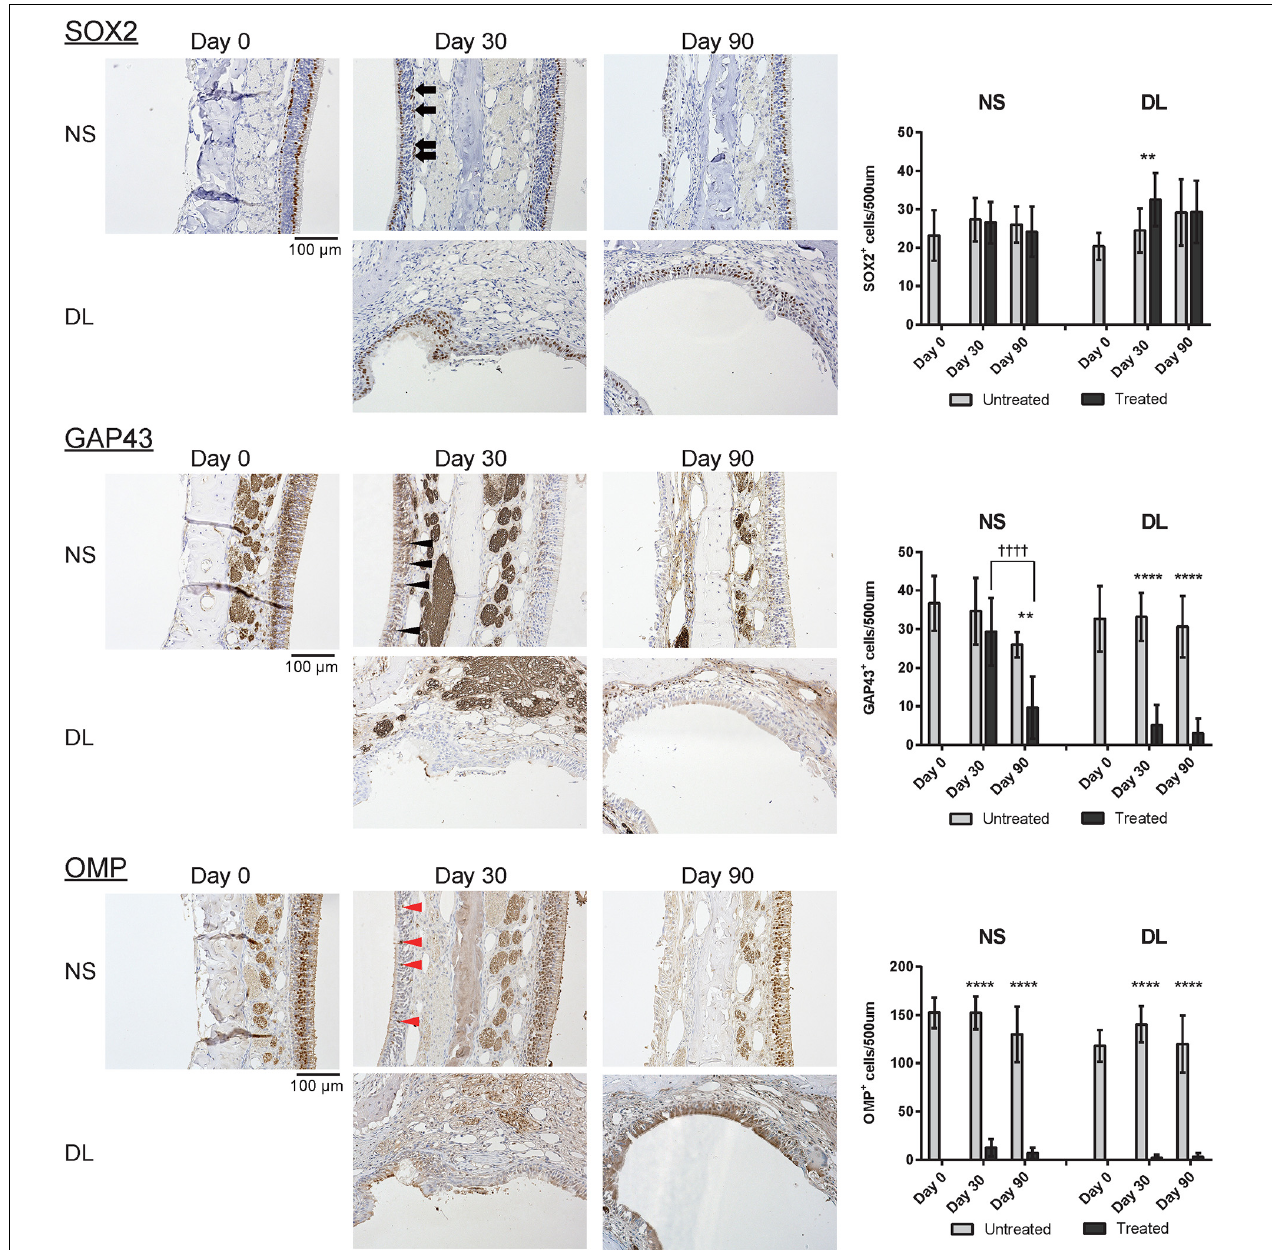
FIGURE 3 | Representative images of sections of the nasal mucosa stained with antibodies against OMP, SOX2, and GAP43 (magnification, 200 × ). OMP + mature olfactory receptor neurons (ORNs), SOX2 + ORN progenitors, and GAP43 + immature ORNs in the epithelium were identified by immunohistochemical staining (brown). On day 30, mature OMP + ORNs were sparse (red arrowheads), whereas GAP43 + immature ORNs (black arrowheads) were more frequently observed in the epithelium of the nasal septum (NS). In the upper lateral (DL) area, SOX2 + cells (black arrows) but no GAP43 + or OMP + cells were present in the epithelium. On day 90, neither GAP43 + immature ORNs nor OMP + mature ORNs were present in the epithelium of the NS or DL area. Graphs show the number of each cell type per 500 µ m of basal layer length. Asterisks indicate a significant difference between the treated and untreated groups. Daggers indicate a significant difference between time points. ** P < 0.01; **** P < 0.0001, †††† P < 0.0001 ( n = 6, two-way analysis of